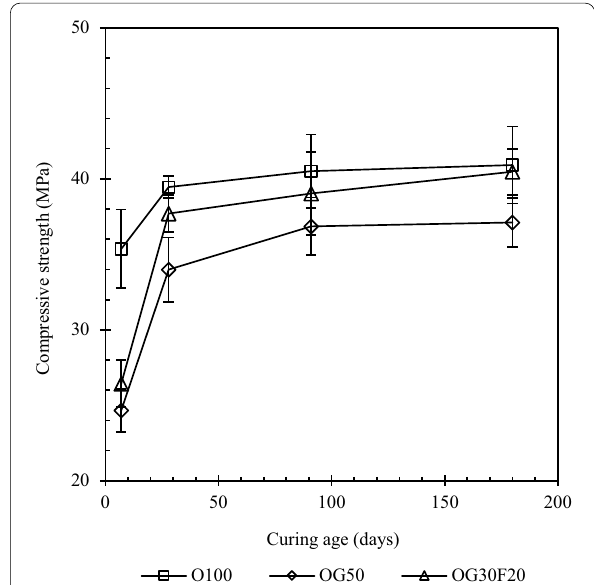
Fig. 5 Compressive strength of OPC–GGBS–FNS mixed concretes with curing age.